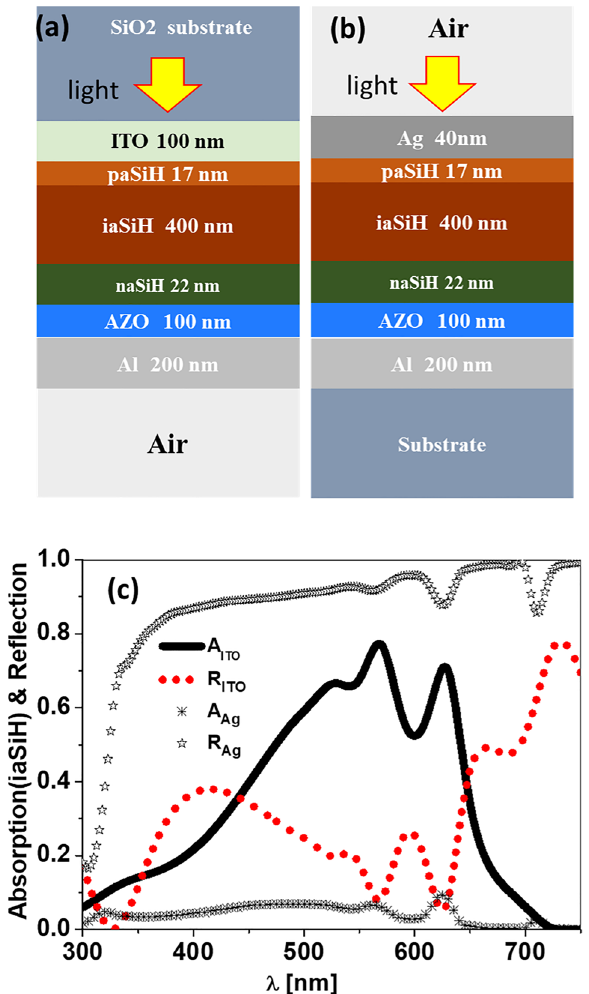
Figure 1. ( a ) Layered structure of conventional aSiH thin film solar cell with top transparent electrode made of ITO. ( b ) The same device where ITO is replaced with a non transparent metallic contact from Ag. ( c ) Absorption at the active layer and total reflectance of a conventional aSiH thin film solar cell with ITO electrode ( A ITO , R ITO ) and for the device with Ag electrode ( A Ag , R Ag